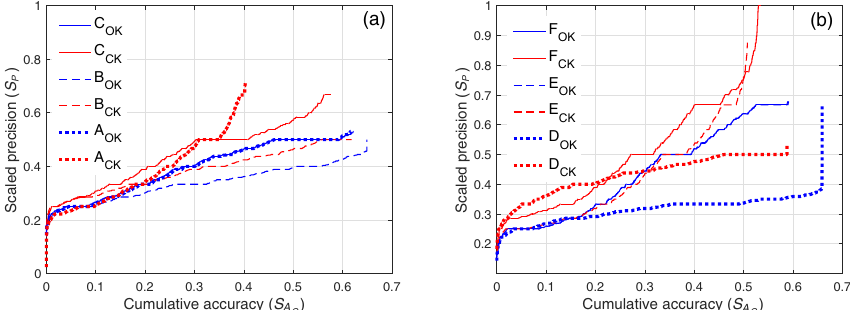
Figure 9. Scaled precision (Eq. 31) plotted as a function of cumulative accuracy (Eq. 34) for estimation cases [ A ; B ; C ] to the left (a) , and [ D ; E ; F ] to the right (b) . Model parameters are given in Table 3. Ordinary kriging (OK) yields the highest accuracy for most cases, but co-kriging CK gave the overall highest precision.